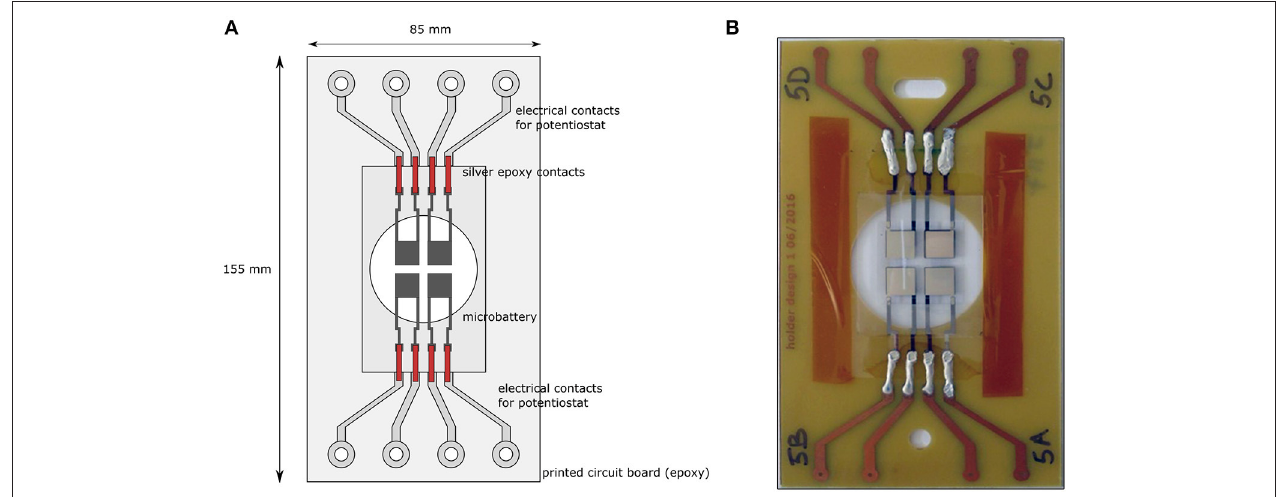
FIGURE 1 | (A) Circuit schematic and (B) an example of a printed circuit board with all solid-state microbatteries prepared by sputtering.